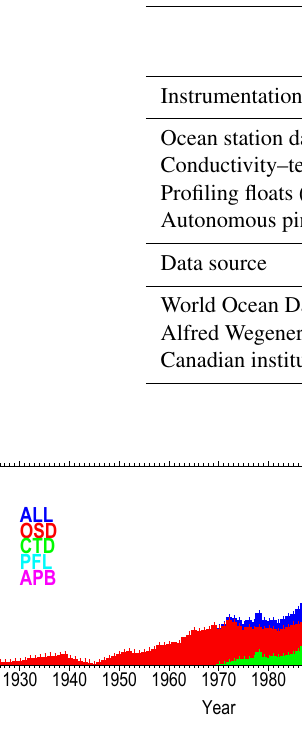
Figure 1. Yearly number of profiles for each data type.